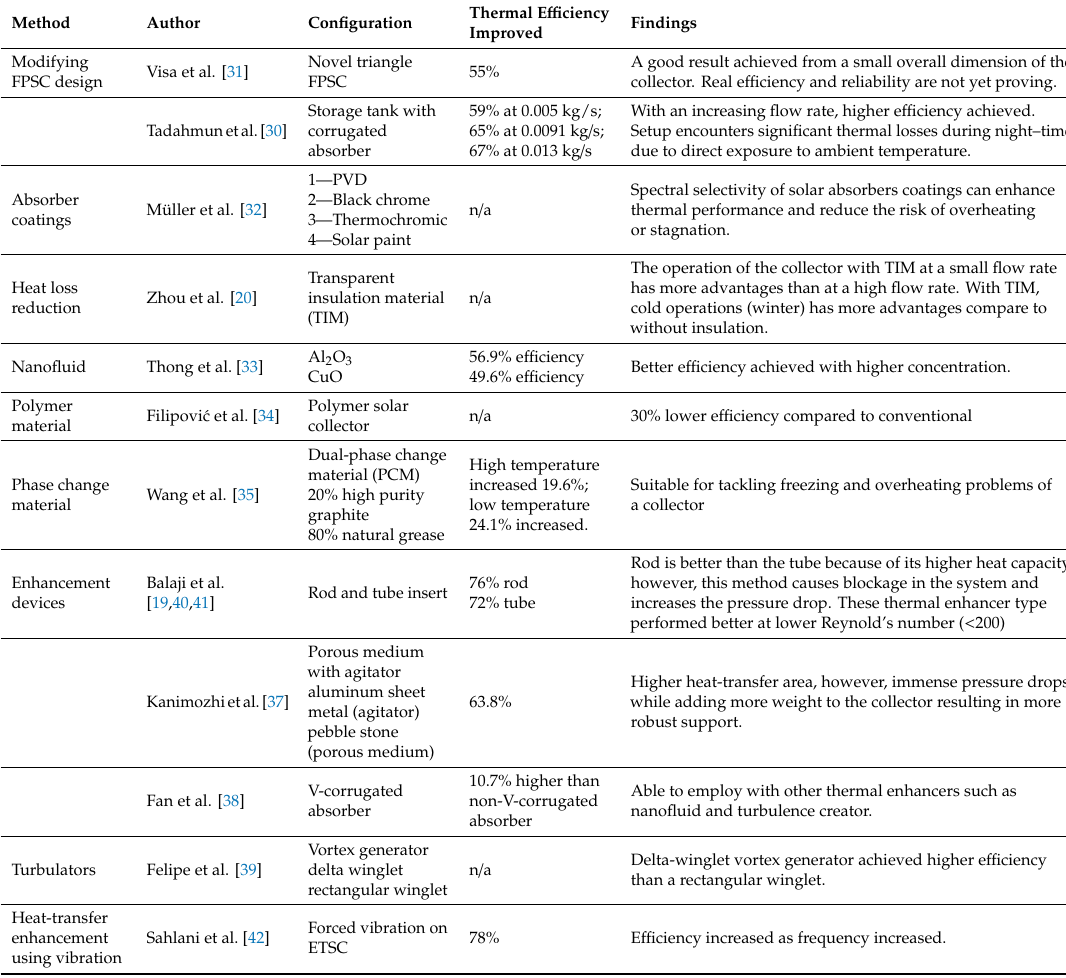
Table 2. Recent studies (late 2019) in FPSC thermal performance enhancement and heat-transfer enhancement using vibration on